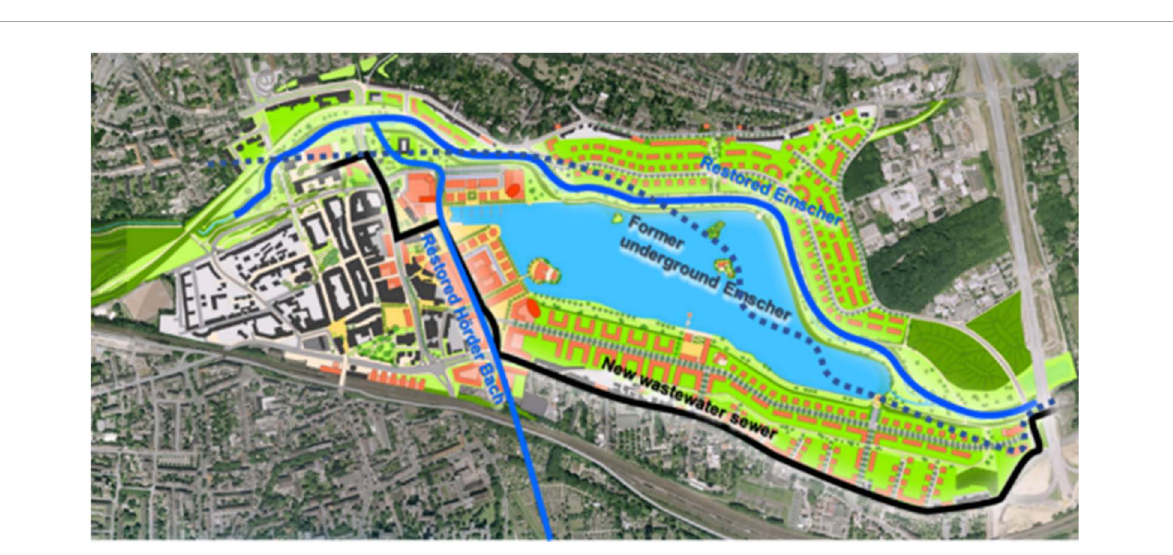
FIGURE6 Map of Lake Phoenix with restored Emscher and Hörder stream (blue) as well as former underground Emscher (dotted line) and the new underground sewer